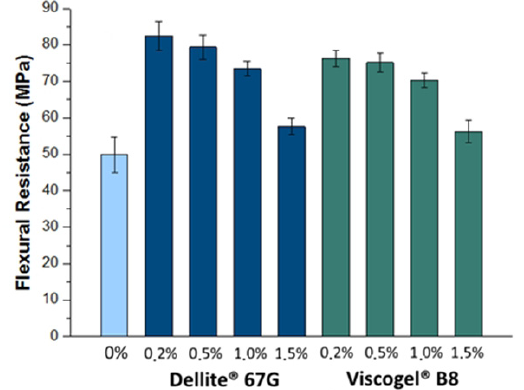
Figure 4. Flexural resistance of the dental adhesives containing different percentages of nanofillers